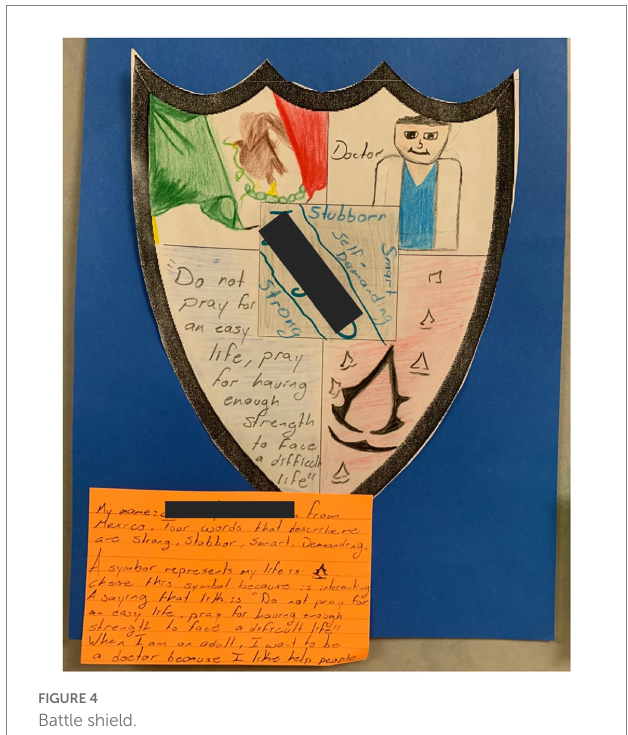
FIGURE 4 Battle